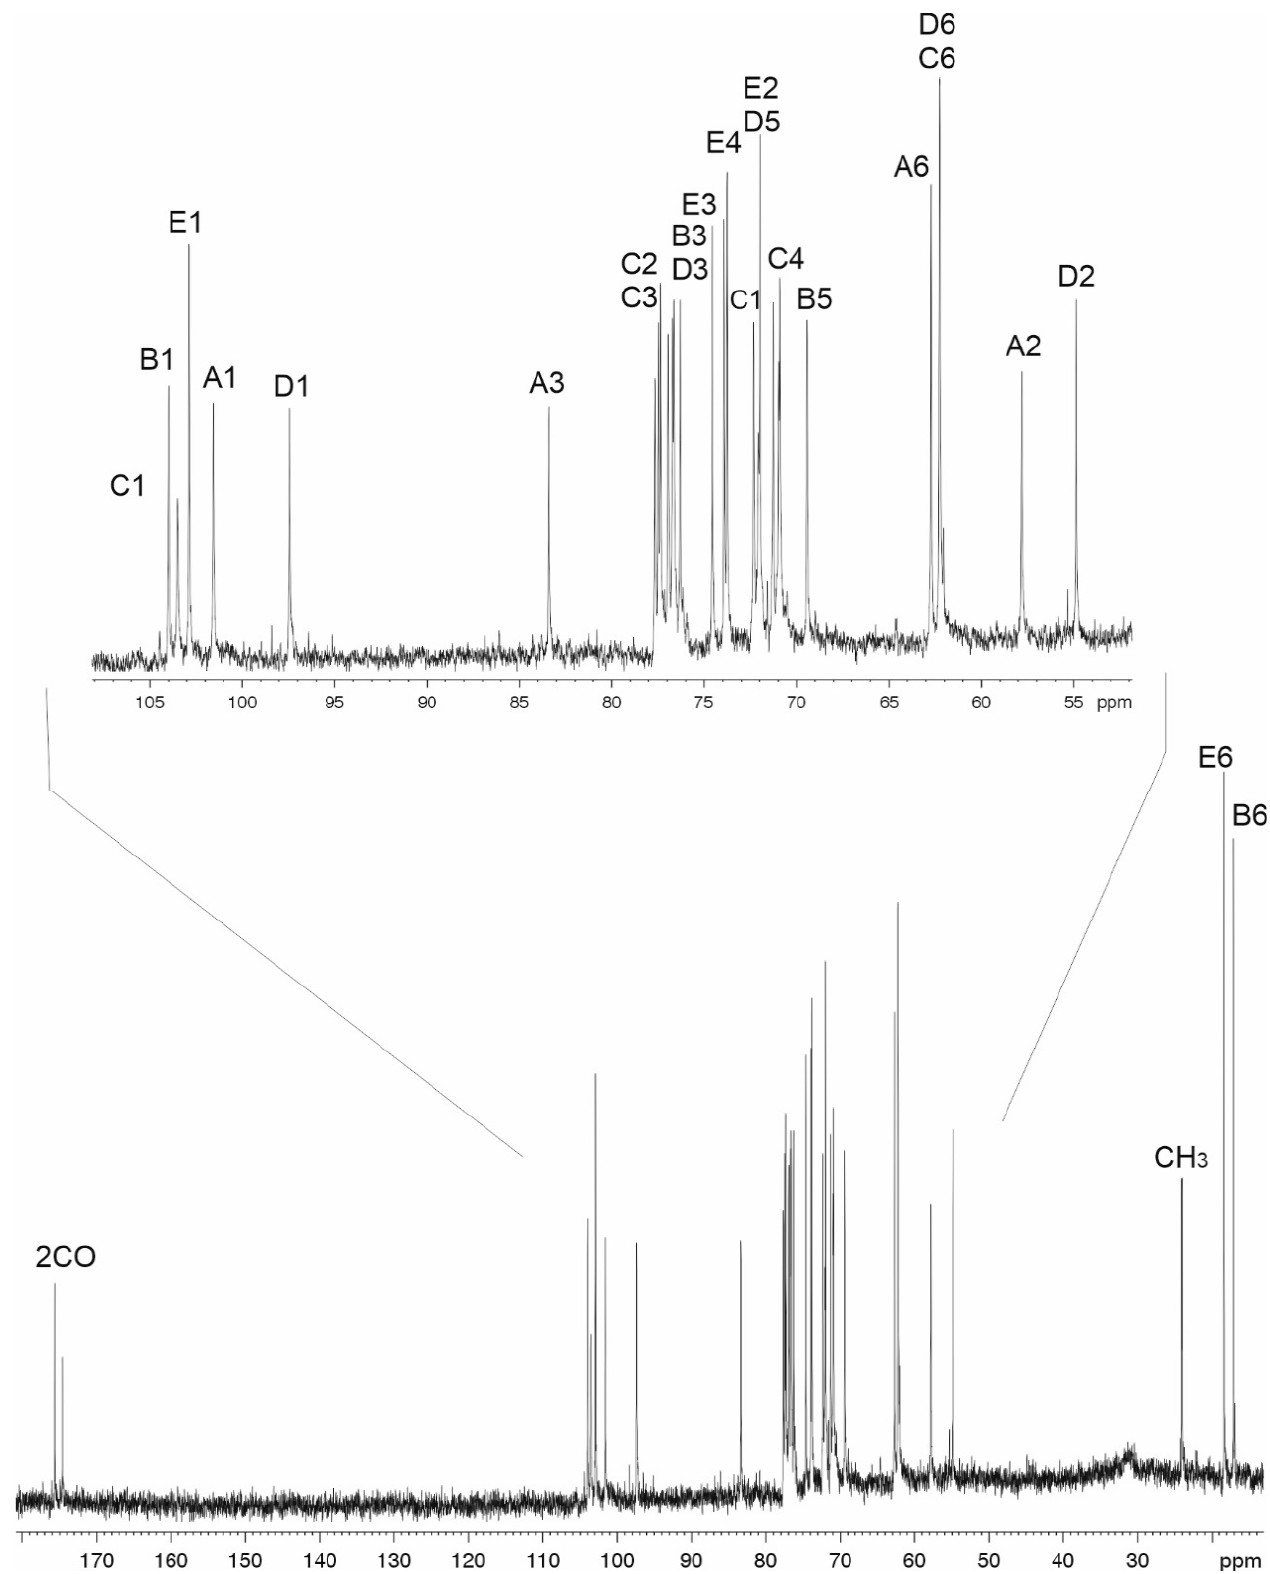
Figure 4. 13 C NMR spectrum of the CPS of A. baumanii K112 (MAR24). Figure 4. 13C NMR spectrum of the CPS of A. baumanii K112